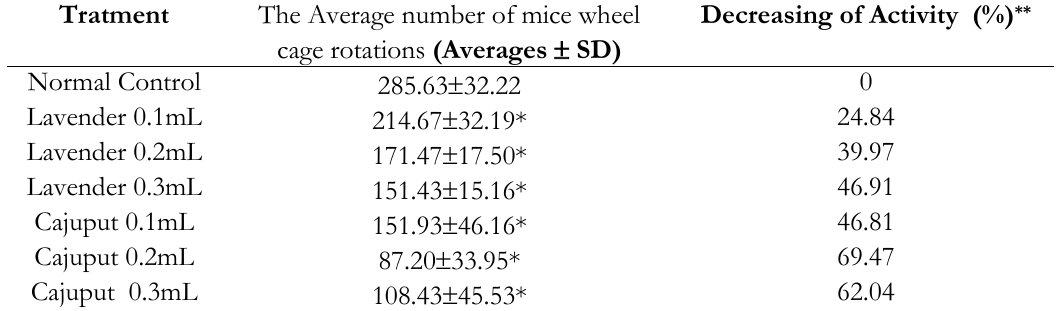
Table II. Average number of mice wheel cage rotations within 90min of inhalation of nutmeg and lavender essential